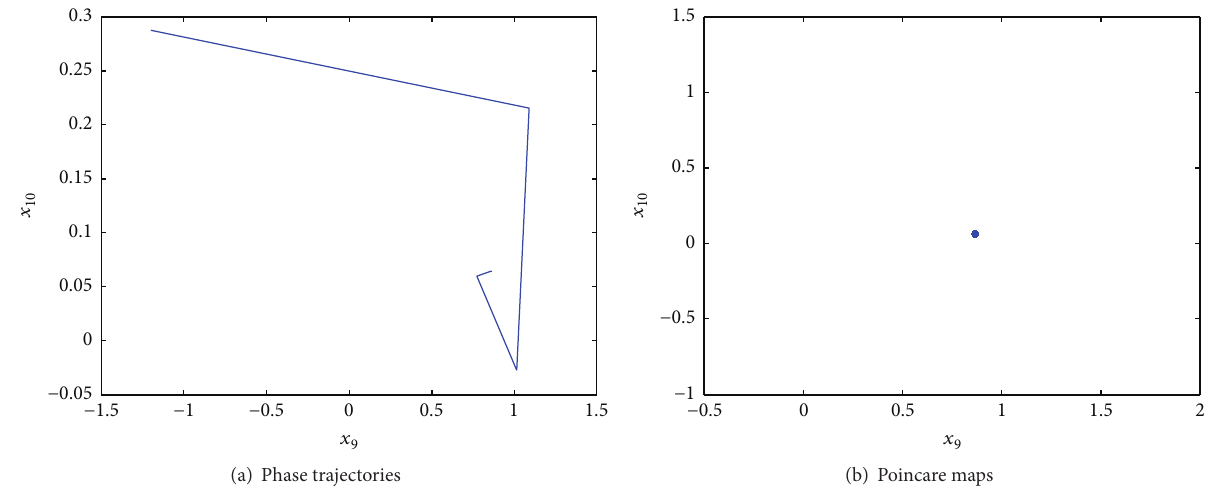
Figure 4: 𝜔 = 110 without random